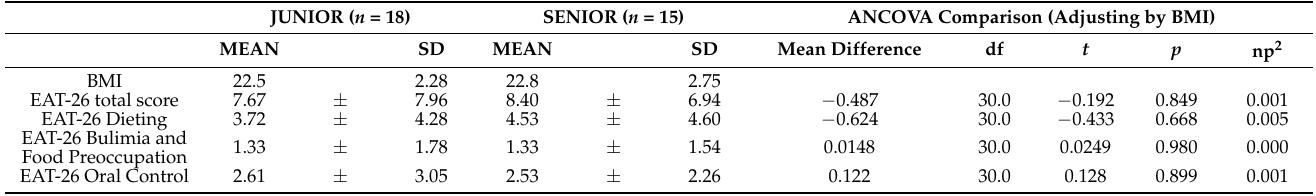
Table 2. Female beach handball (BH) players descriptive and comparison different EAT-26 subscales (junior vs. senior). JUNIOR ( n = 18) SENIOR ( n = 15) ANCOVA Comparison (Adjusting by BMI)